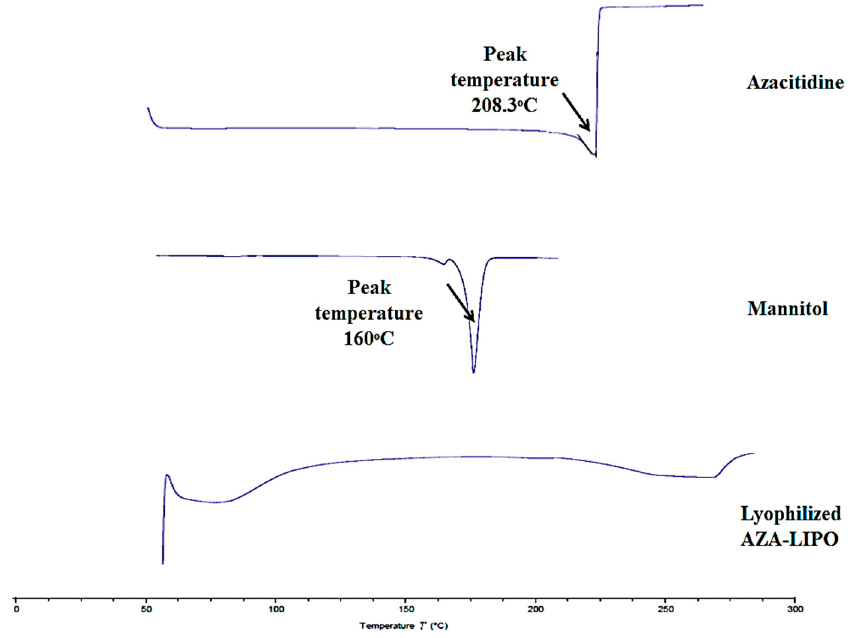
Figure 6. Comparative DSC thermo gram of AZA, excipients and AZA-LIPO formulation.